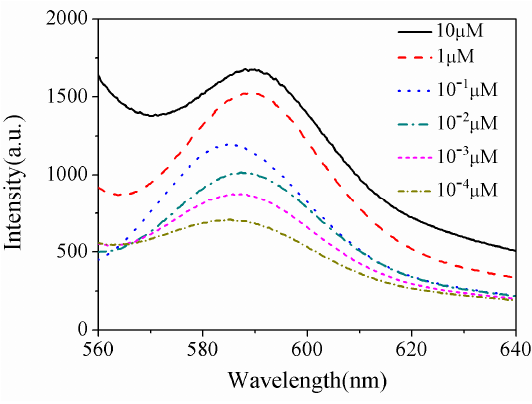
Figure 11. The fluorescence spectra of RRA-DNA with varying concentrations.